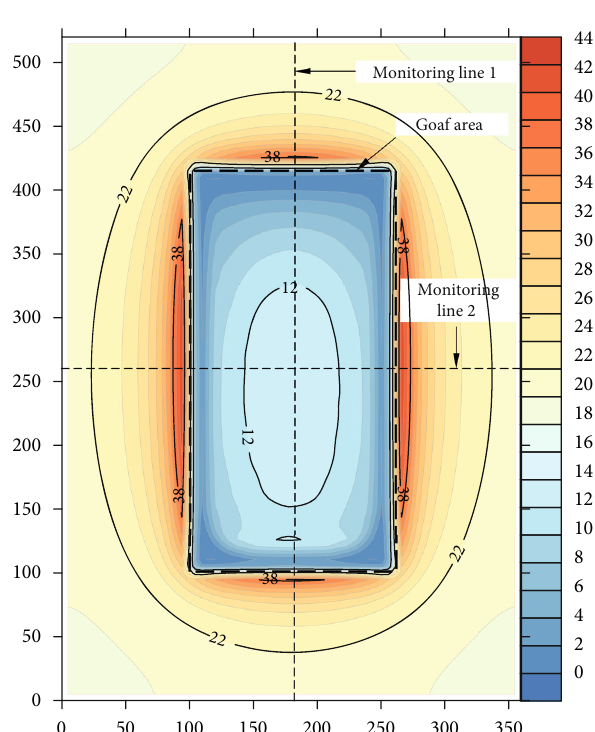
Figure 5: Layout of the stope excavation and fi lling.